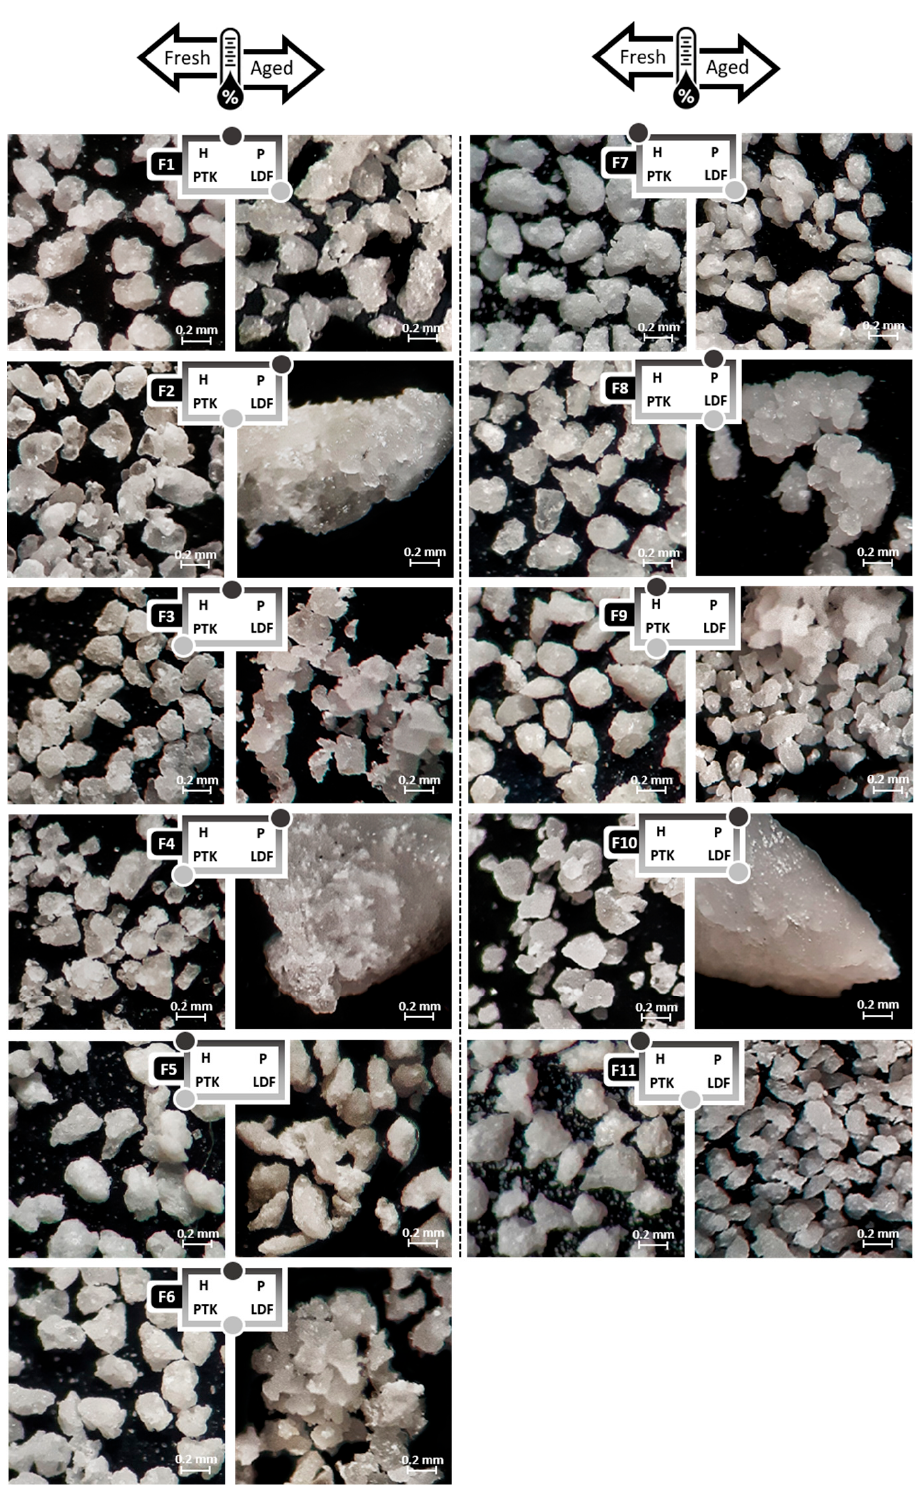
Figure 2. Optical microscopy photomicrographs of effervescent extrudates obtained according to a combined mixture design before and after aging at a 45× magnification.